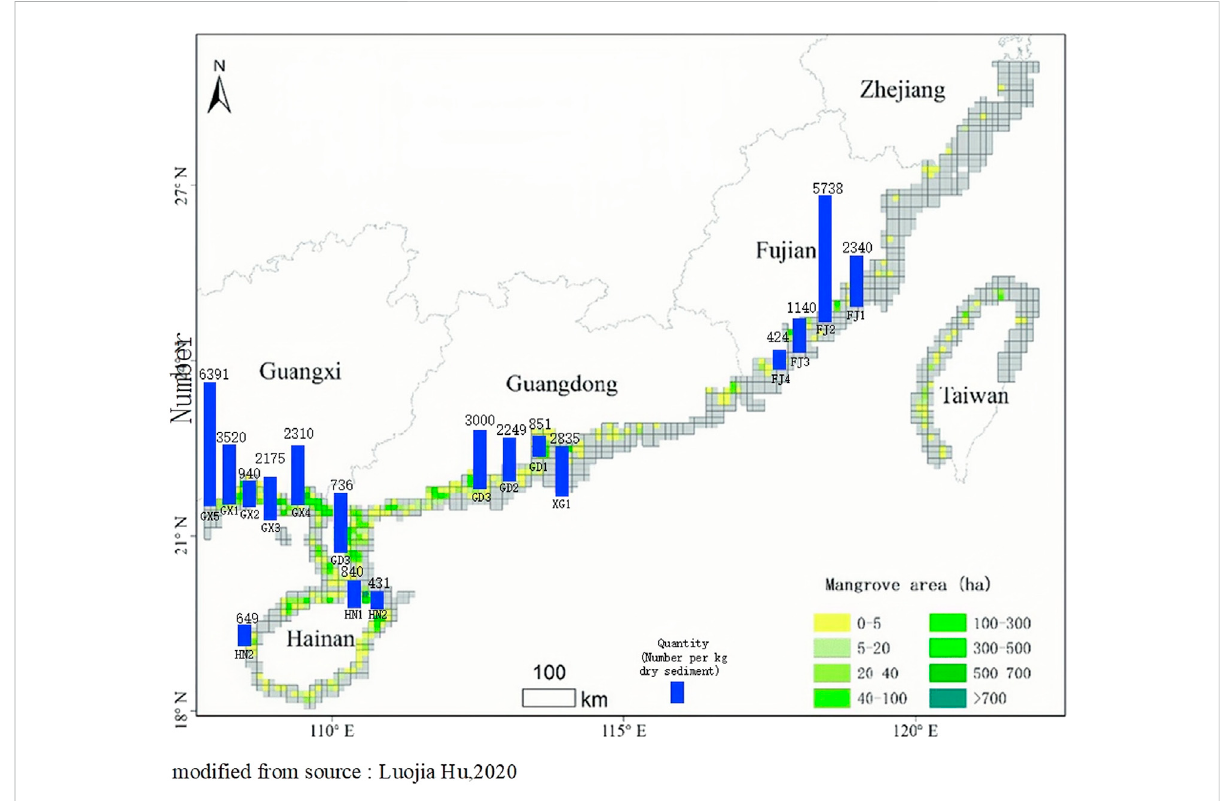
FIGURE 4 Distribution of microplastic pollution in mangrove wetlands of China.